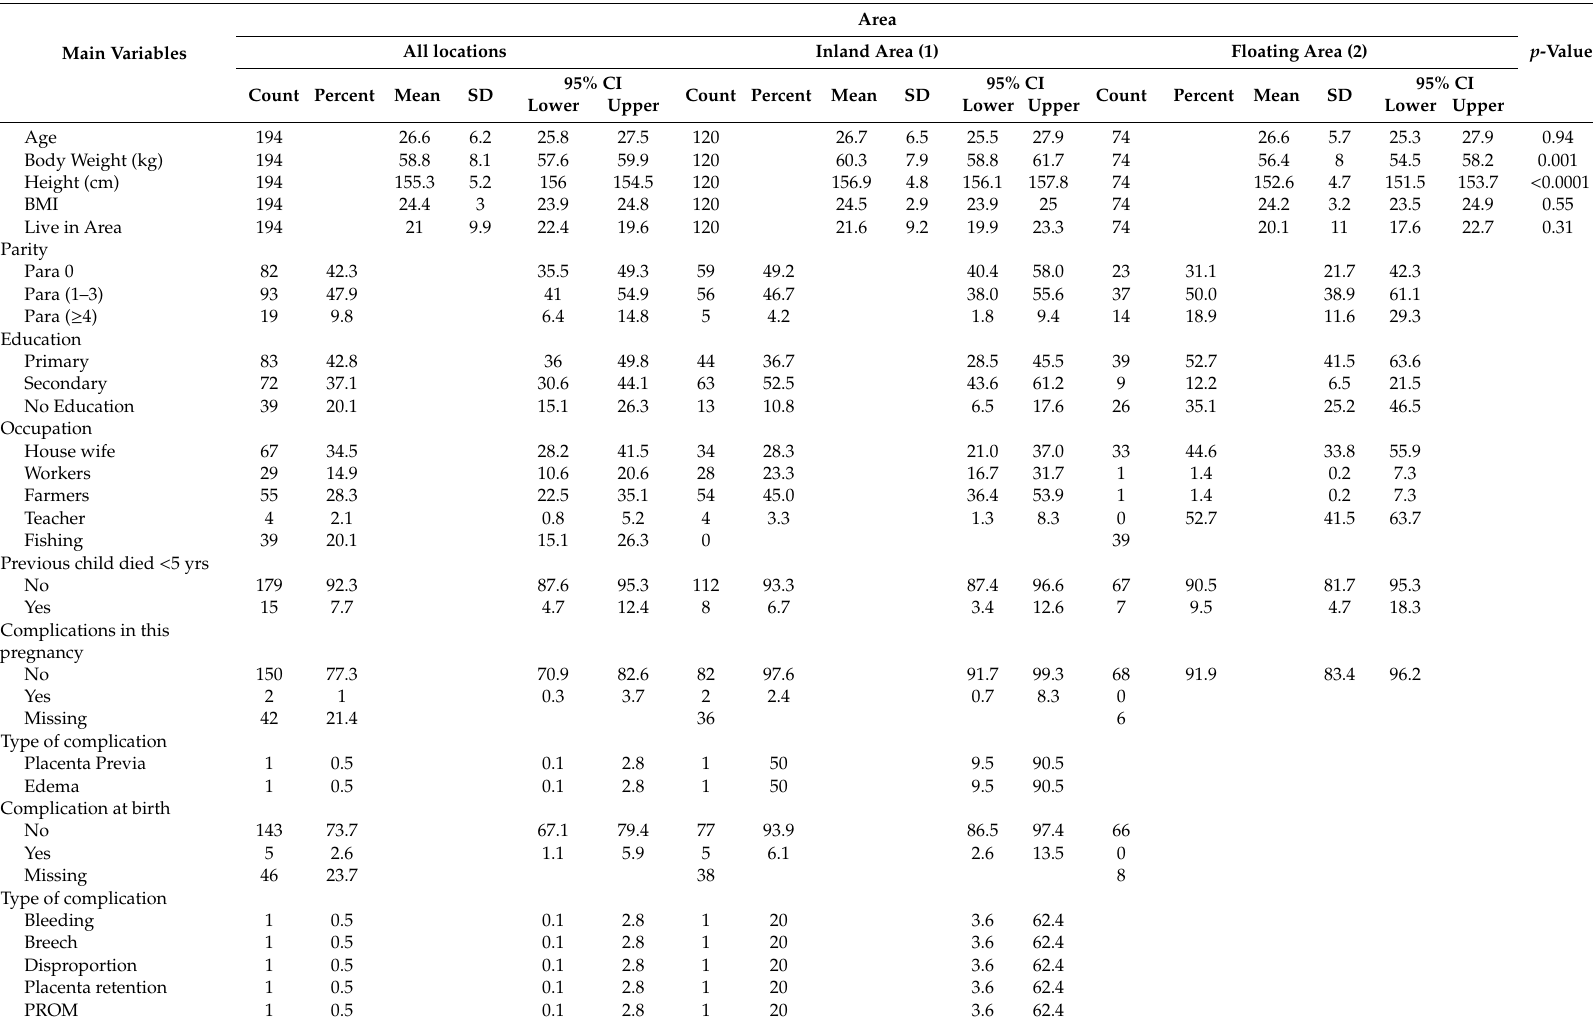
Table 1. Demographic information of the women included in the